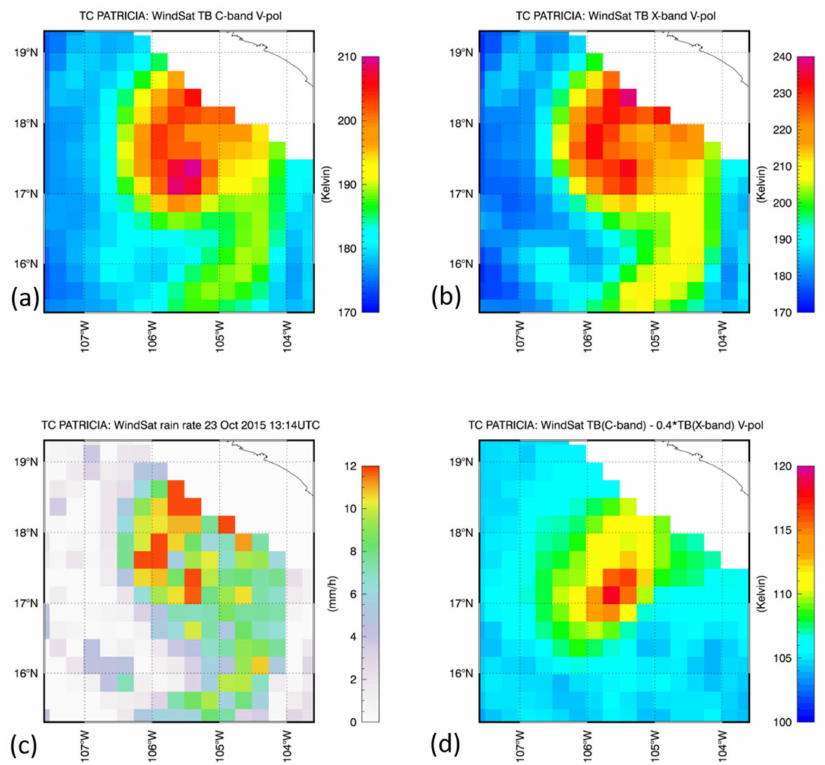
Figure 3. Basic methodology to minimize rain contamination in TC wind speed retrieval for the WindSat passes over Hurricane Patricia (Figure 2): ( a ) WindSat 6.8 GHz TB vertical polarization. ( b ) WindSat 10.7 GHz TB vertical polarization. ( c ) WindSat rain rate. ( d ) Combination 6.8 GHz–0.4 · 10.7 GHz V-pol TB. The rain contamination is reduced in this channel